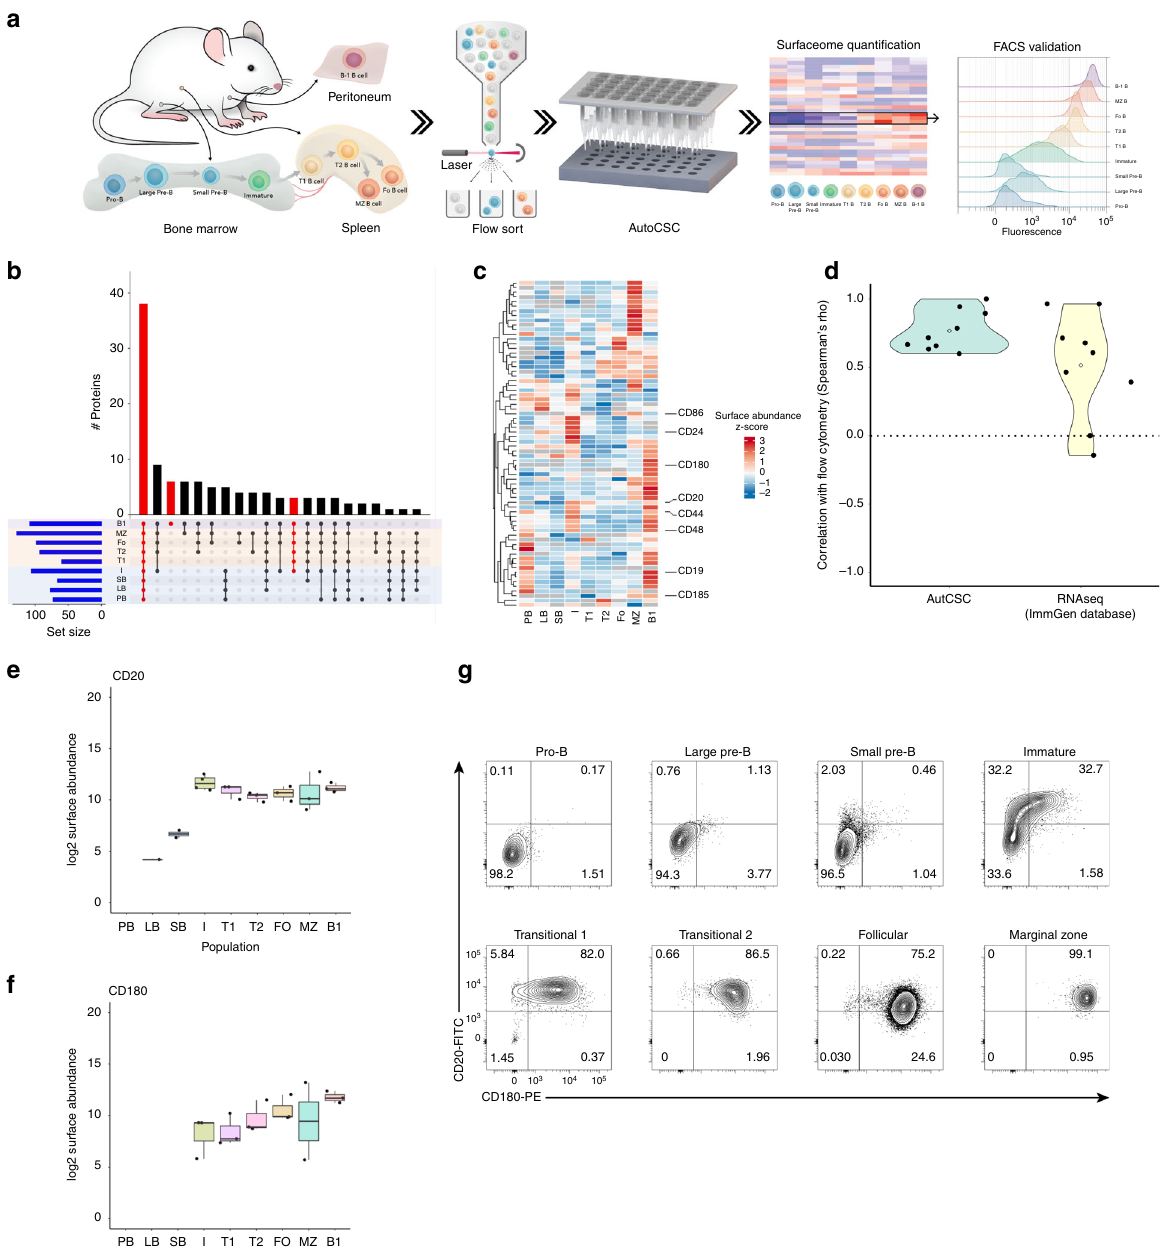
Fig. 2 De novo mapping of developing mouse B cell populations using autoCSC. a Schematic illustration of the work fl ow used to phenotype B cell populations and identify subpopulations. b Quanti fi ed surface protein distribution of developing B cell populations visualised by upset plot. The bar chart on top visualises the number of proteins contained within each intersection as de fi ned in the lower part. c Heatmap of z-score abundance values. Surface proteins used for subsequent fl ow cytometry analysis are indicated to the right. d Correlation analysis (spearman ’ s rho) comparing autoCSC and RNA-seq with fl ow cytometry. e , f Box-plots showing autoCSC obtained surface abundance values for ( e ) CD20 and ( f ) CD180 in B cell populations. The center line of box-plots represents the median, box limits the upper and lower quartiles, whiskers the 1.5x interquartile range and dots any outlier data points. g Flow cytometry distributions of CD20 and CD180 surface abundances during B cell